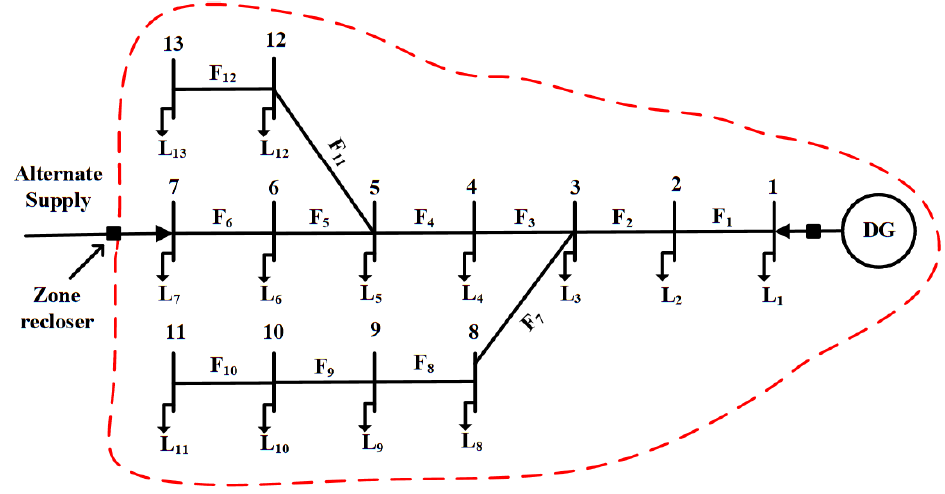
Figure 2. An islanded portion of a RDS having 13 buses, and 13 load